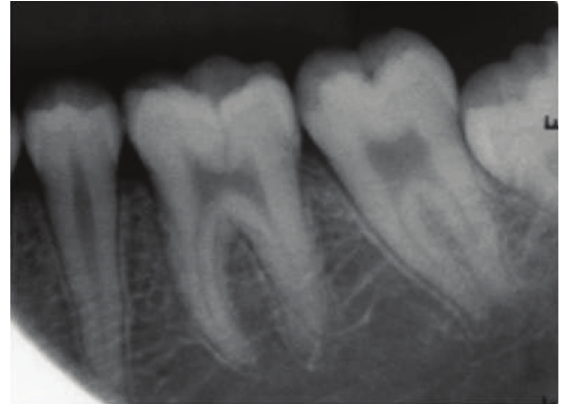
Figure 9: Preoperative view of 36, prior to placing surgical incisions for a full thickness mucoperiosteal flap on lingual aspect.